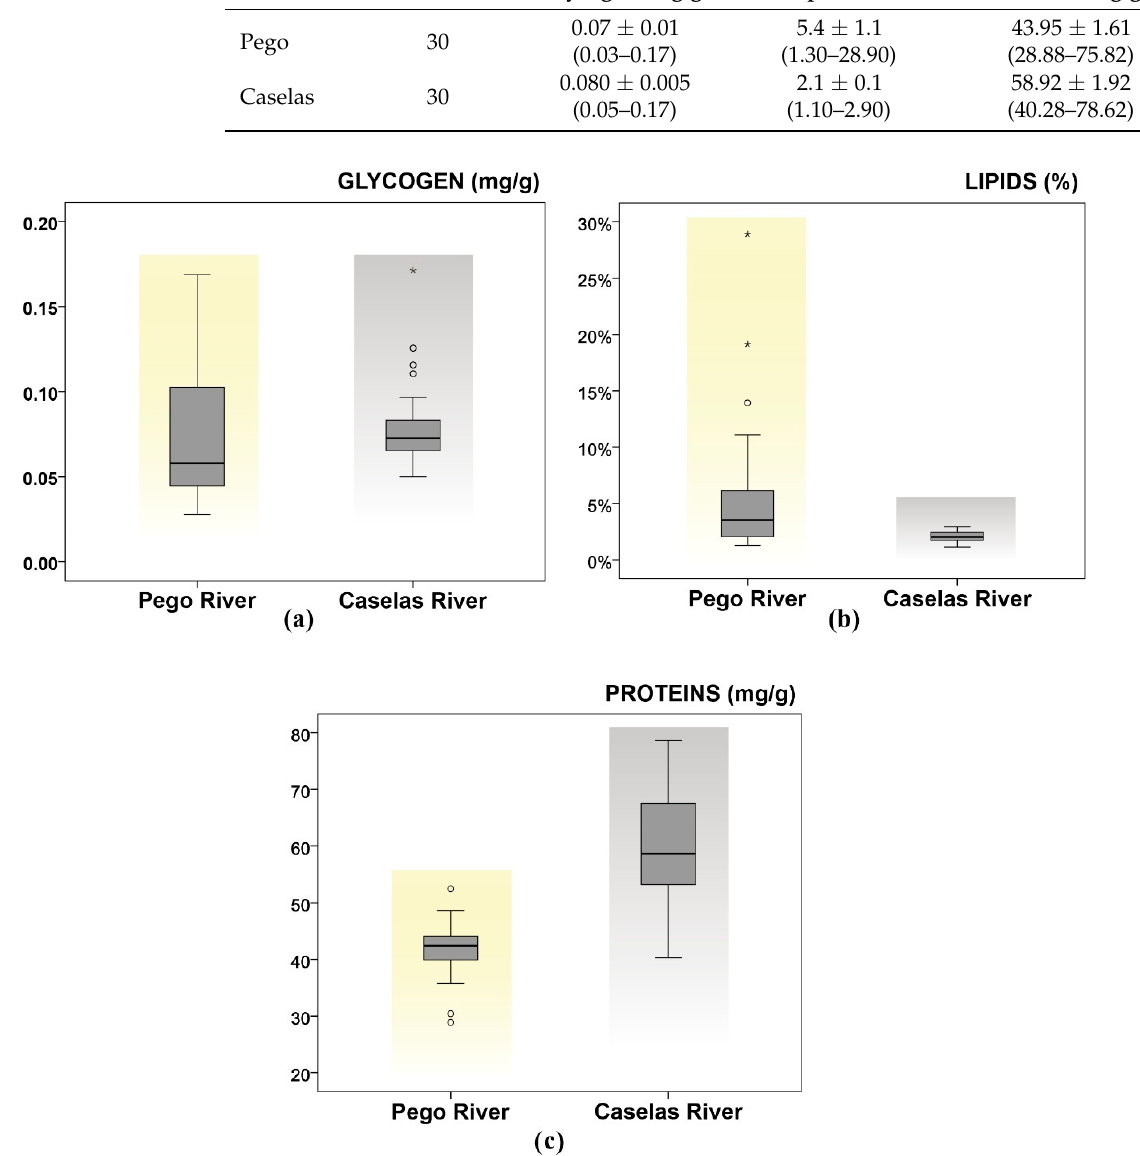
Figure 4. Box plot (median, quartiles, maximum and minimum) of the ( a ) glycogen, ( b ) lipids, and ( c ) proteins values of the individuals of the two studied populations of G. lozanoi.